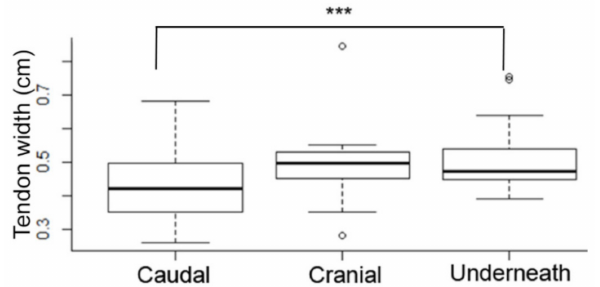
Figure 4. Tendon width versus tendon insertion type ANOVA analysis. When comparing the width of the tendon with the insertion type there was a significance difference only between the width of the caudal and underneath insertions. Meaning that the tendon with a caudal insertion is smaller than the tendon with an underneath insertion type. Cranial insertion versus caudal insertion had a p- value of 0.2 (not significant). Underneath insertion versus caudal insertion had a p 0.001 (***). Cranial insertion versus underneath insertion had a p 0.57 (not significant). The x -axis shows the type of tendon insertion in relation to the LCL.